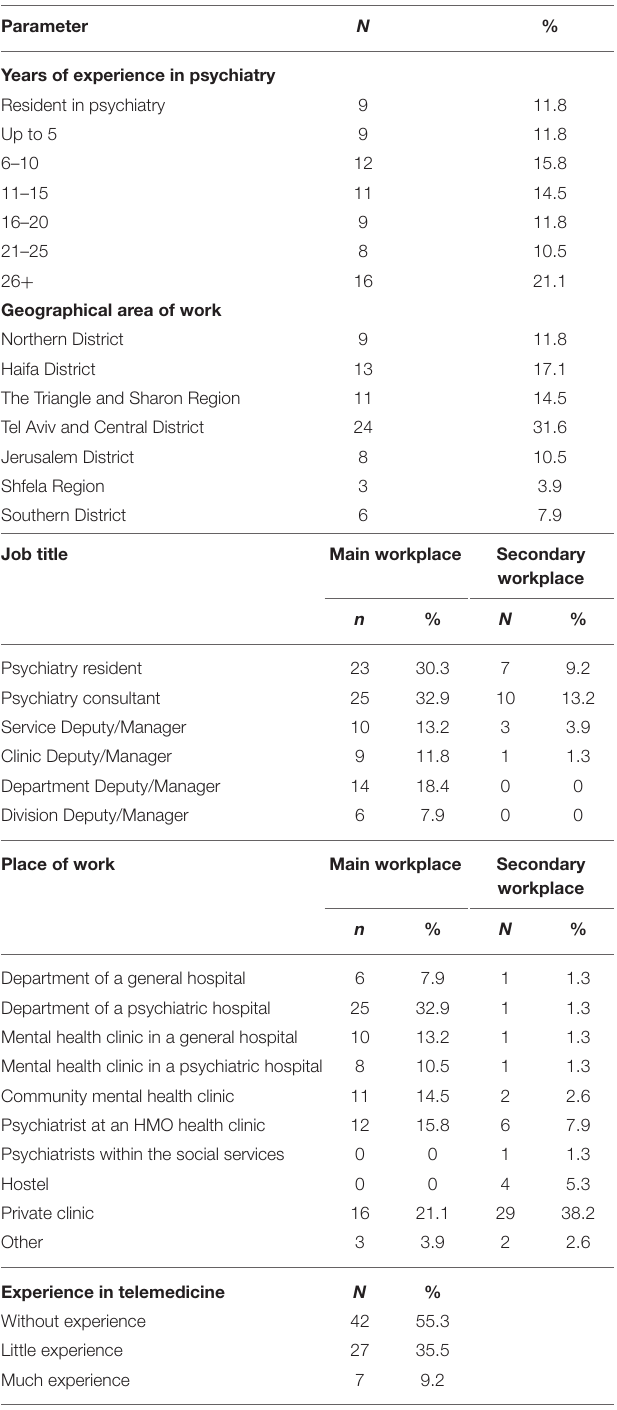
TABLE 2 | Profession-related data of the survey participants ( n = 74, as two participants did not provide demographic data). Parameter N %